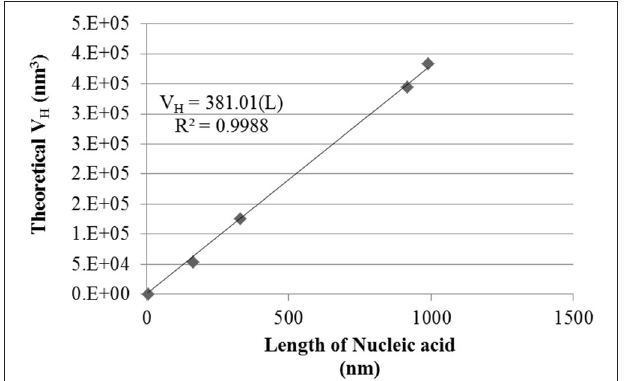
FIGURE 3 | Hydrodynamic Volume (V H ) of size minimized nano-complexes of different lengths of nucleic acid. Data shown is a conversion of the mean nano-complex size to hydrodynamic volume under the approximation of a sphere. The linear regression was forced through zero. R 2 and regression equation are shown, where “L” is the length of the nucleic acid.